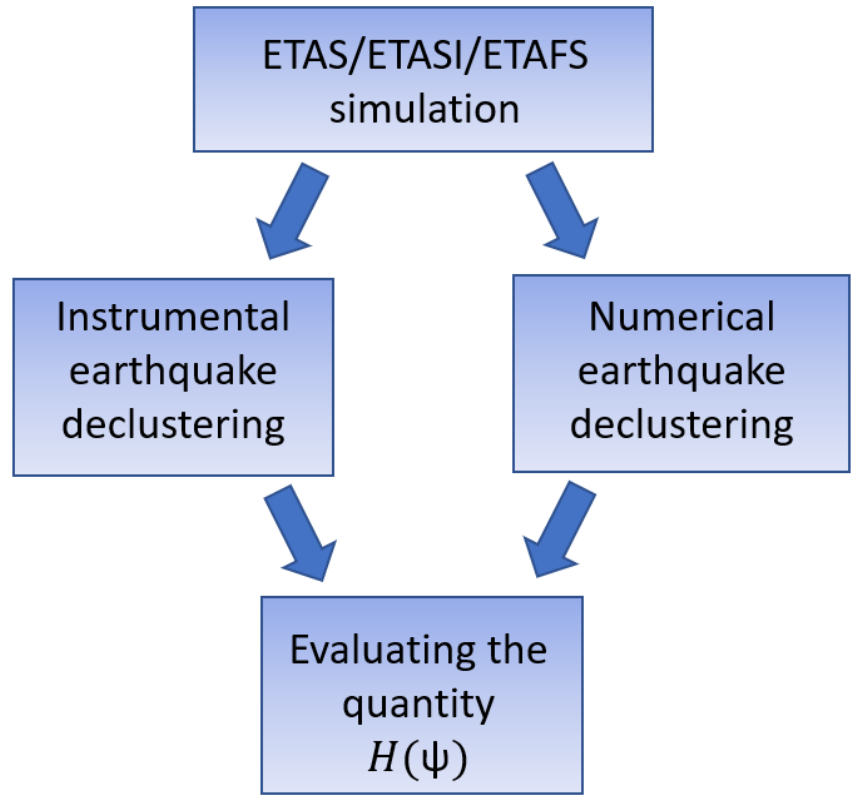
Figure 3. Flowchart of the method employed in the